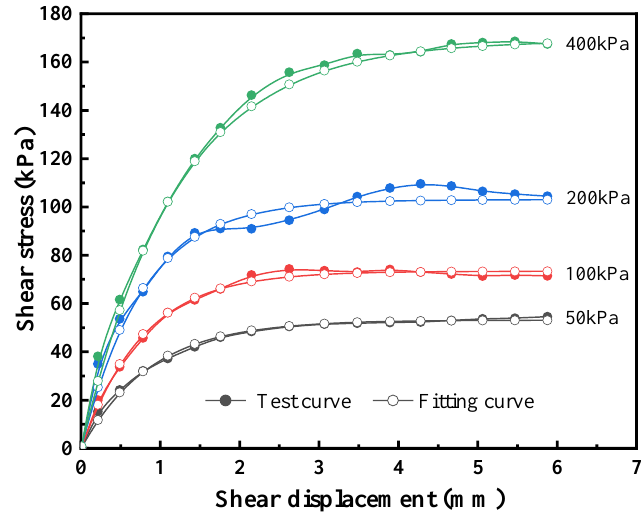
Figure 9. Comparison of test curve and fitting curve (w = 10%).